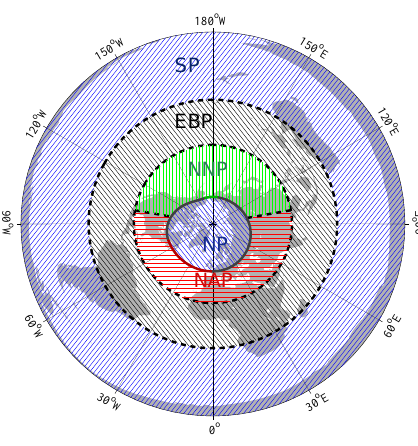
Figure 5. Patching scheme for the global grid.